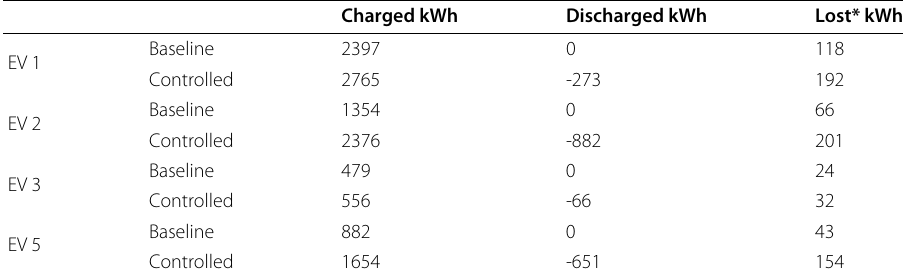
Table 4 Energy balances using